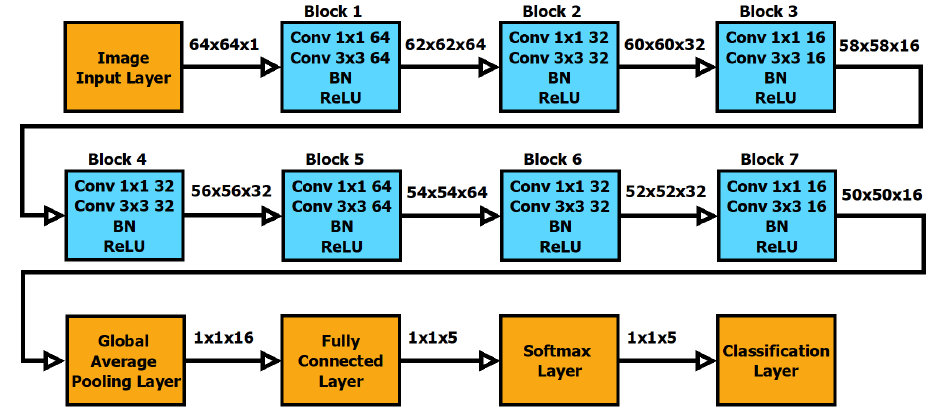
Figure 5. Block diagram of proposed CNN.